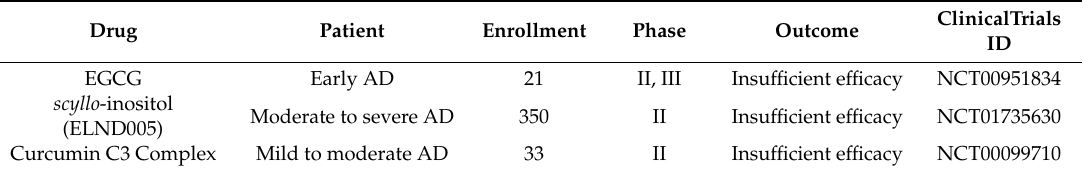
Table 2. Failed clinical studies of natural products targeting A β